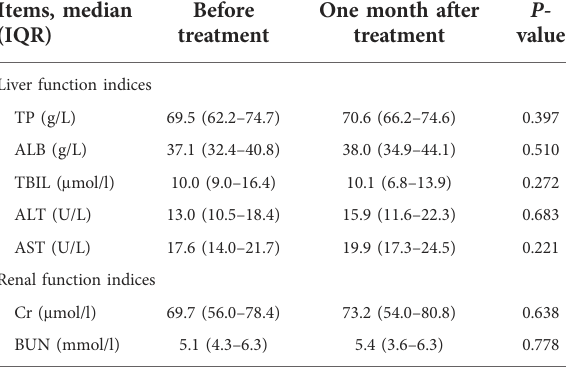
TABLE 5 Biochemical